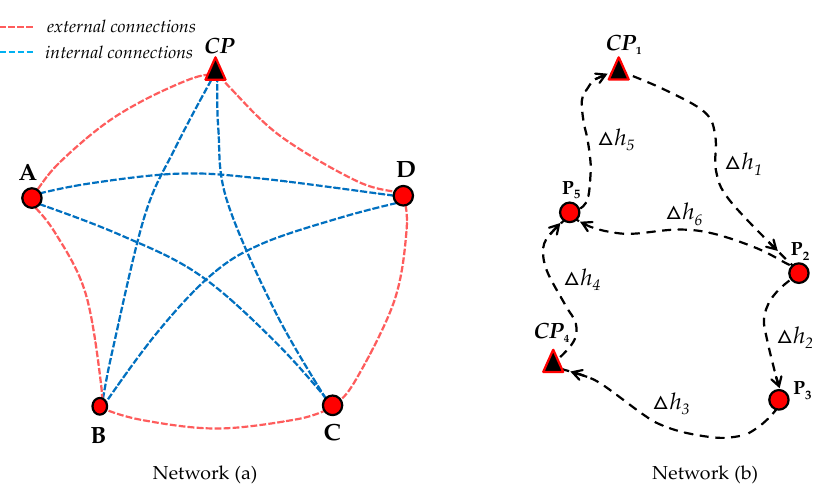
Figure 2. Levelling geodetic networks: ( a ) Levelling network adapted from [60] with a low correlation between w -test statistics; ( b ) Levelling network adapted from [43] with a high correlation between w -test statistics.